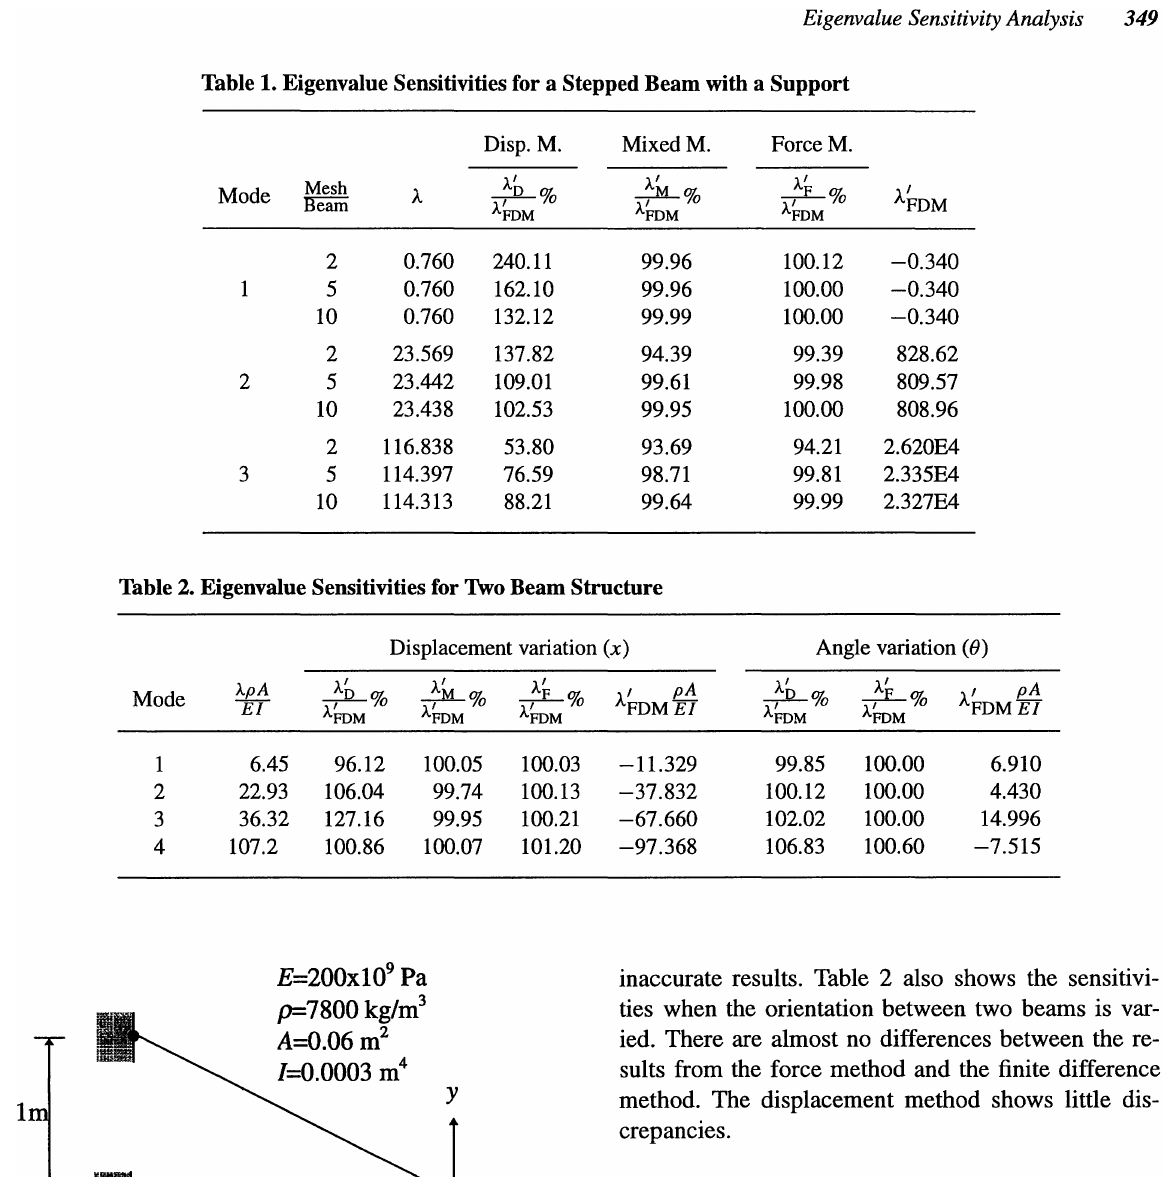
Table 1. Eigenvalue Sensitivities for a Stepped Beam with a Support Disp. M.